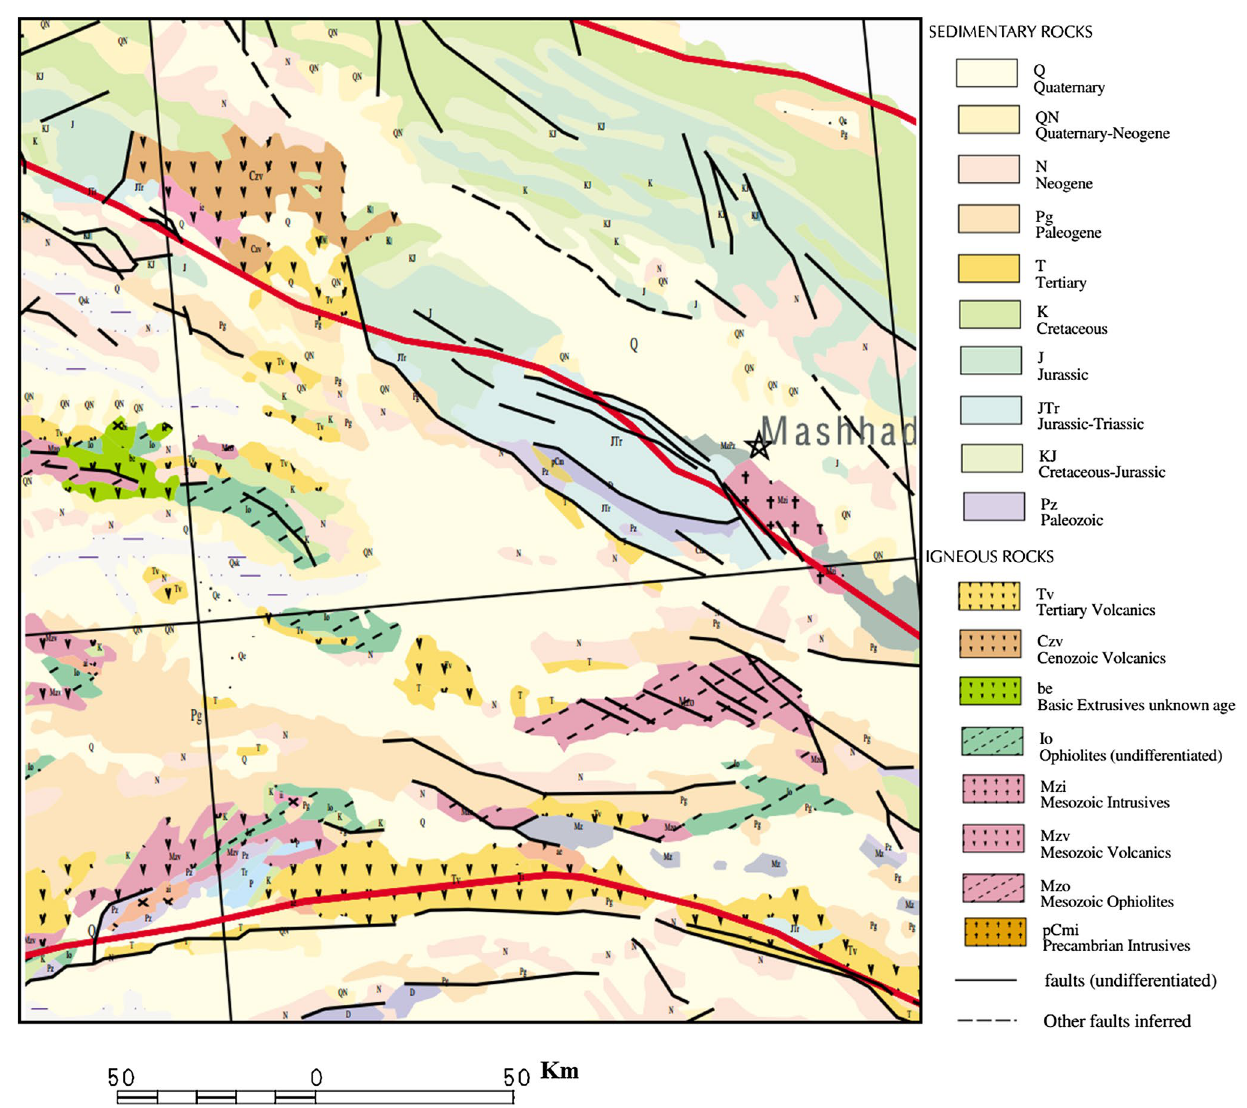
Fig. 2 Lithological map of the study area ( Source: sill ratio, C0/(C0 + C1), was calculated to characterize the spatial dependency of the values. In general, a nugget/sill ratio 75% indicates weak spatial dependency; otherwise, the spatial dependency is moderate (Cambardella et al. 1994).